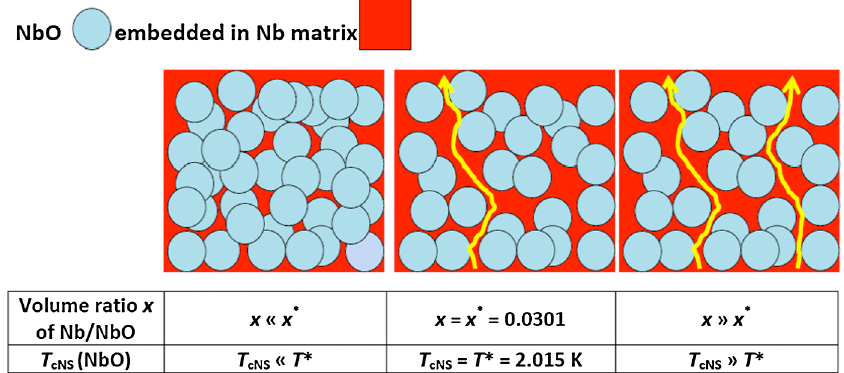
FIG. 3. Schematic of a cluster of equally sized spheres below (left) and above the percolation threshold (middle and